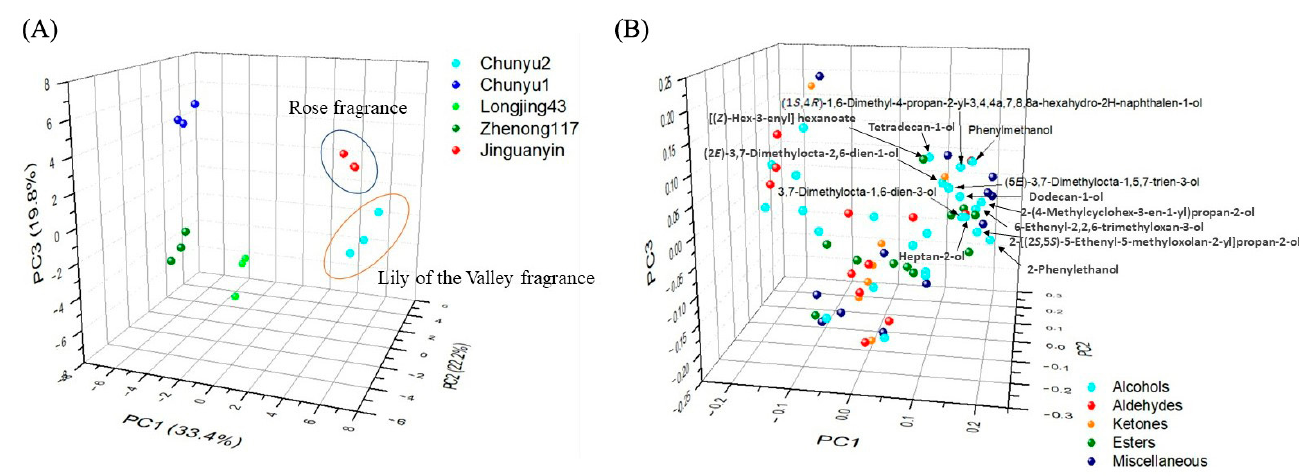
Figure 3. The PCA result of green tea samples from different tea cultivars based on the volatile compositions. ( A ) score plot; ( B ) loading plot. The number of replicates is equal to 3.